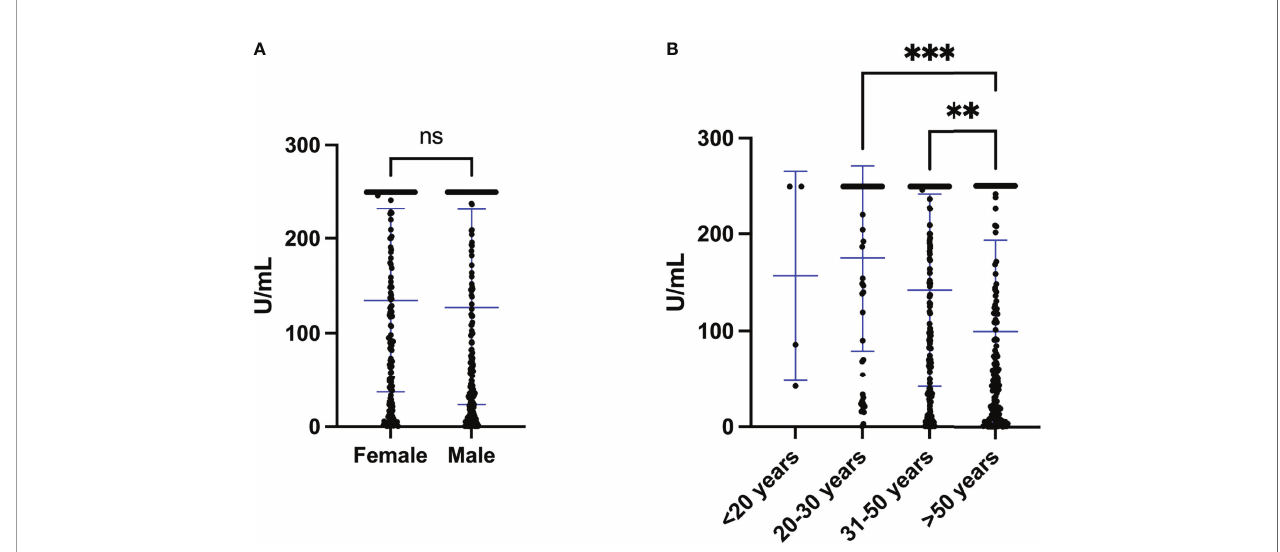
*Percentage of donors with negative/positive spike values of female/male in that group. **Percentage of donors with negative/positive spike values with other clinical issues of female/male in that group. ***Some donors in this group had spike antibody levels >250 U/mL.